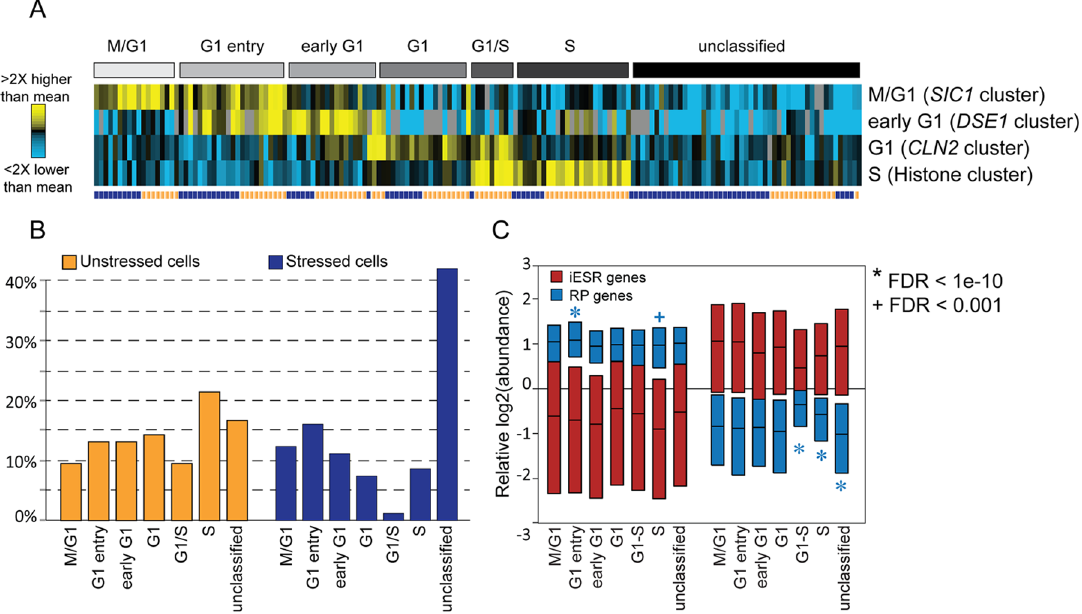
Fig 5. The influence of cell-cycle phase on ESR activation. Cycling genes used for classification were identifiedby clustering the scRNA-seq data [54] and then selectingclusters enriched for cell-cyclemarkers (S3 Table, see Methods). (A) Cells (columns)were clustered basedon the centroidexpressionpattern of geneswithin each group (rows) and manually classifiedinto and sorted within designated groups (A, grey bins, S9 Table). Stressed and unstressedcells are annotated by the purple/orange vector (A, bottom row). (B) The percentage of cells in each cell-cyclephase. Cell phases are listed in S5 Table. (C) Boxplots (without whiskers) of all iESR (red) or RP (blue) genes from cells in that phase. Significance was assessed by Welch t test on the pooledRP or iESR genesfrom cells within a given phasecompared to all other cells; unstressed and stressed cells were analyzedseparately.Note only one cell was classifiedas G1/S after stress. ESR, Environmental Stress Response;iESR, induced-EnvironmentalStress Response;RP, ribosomal protein; scRNA-seq, single-cell RNA sequencing.